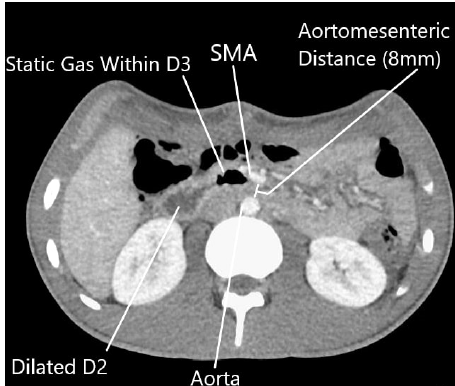
Figure 2. Representative image from upper gastrointestinal series showing abrupt cutoff of oral contrast in the mid-transverse duodenum, suggestive of superior mesenteric artery syndrome.